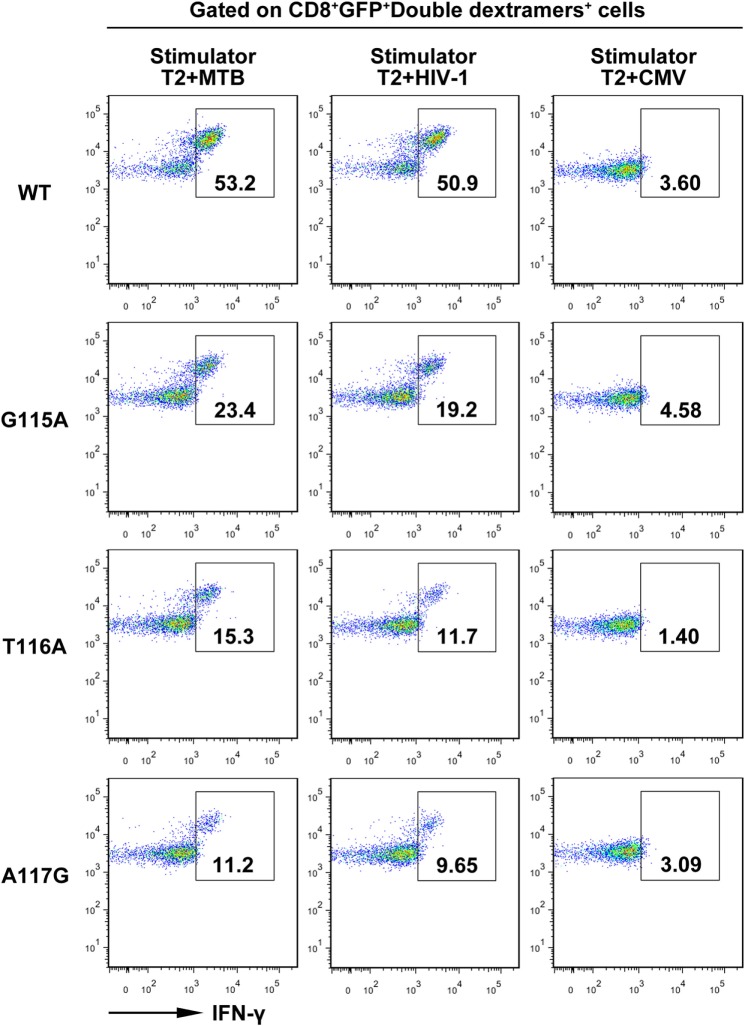
Intracellular staining of transduced CD8+ T cells for interferon-γ (IFN-γ) production. Shown are the resultant FACS scatter plots for CD8+ T cells transduced with WT, G115A, T116A, or A117G T cell receptor vector. Cells were cocultured with T2 pulsed with MTB Ag85B199–207, HIV-1 Env120–128, or control peptide CMV pp65495–503. Cells were gated for CD8+GFP+double dextramers+ cells and then analyzed for intracellular IFN-γ.